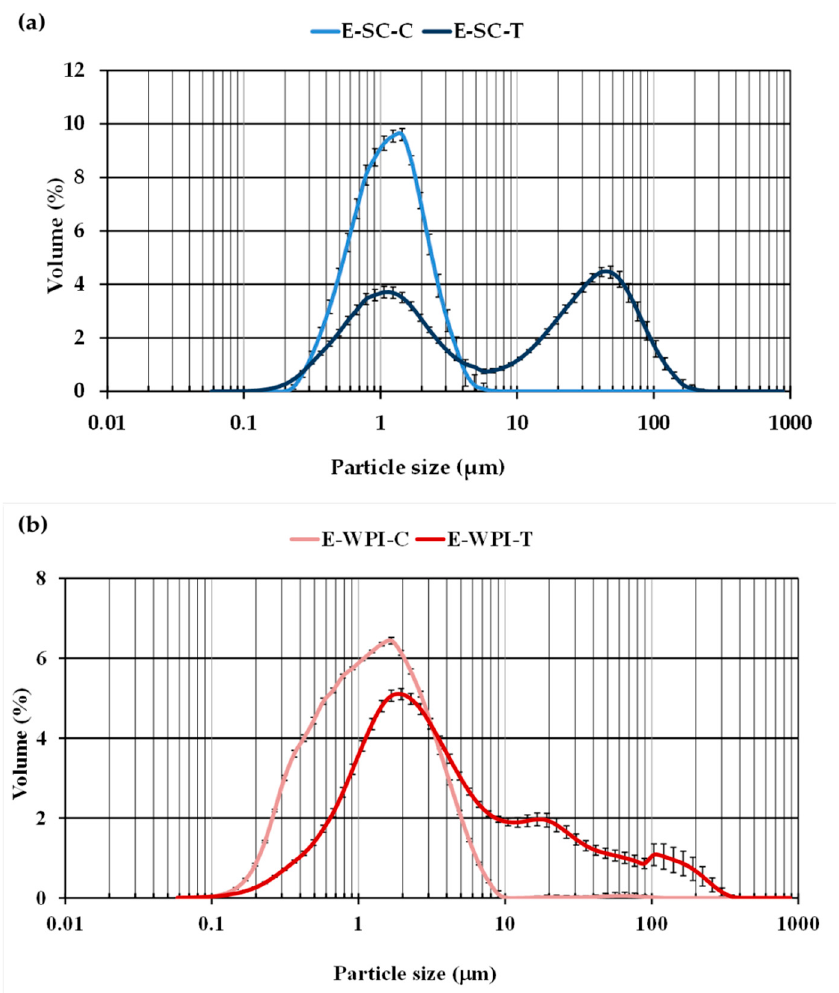
Figure 1. Droplet size distributions for liquid-like emulsions (Es): ( a ) stabilized by SC without and with added condensed tannins (E-SC-C and E-SC-T); ( b ) stabilized by WPI without and with added condensed tannins (E-WPI-C and E-WPI-T).